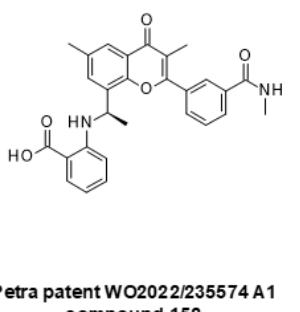
Figure 10. Compound HL-8: a recently reported PROTAC degrader of PI3K.